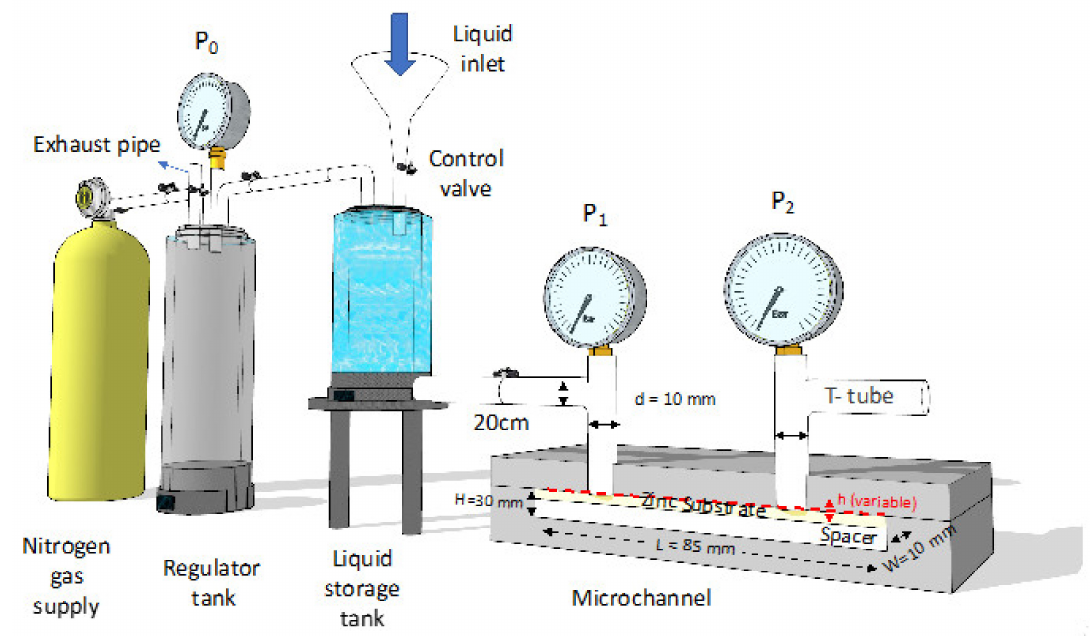
Figure 2. Non-standard design microchannel flow resistance test